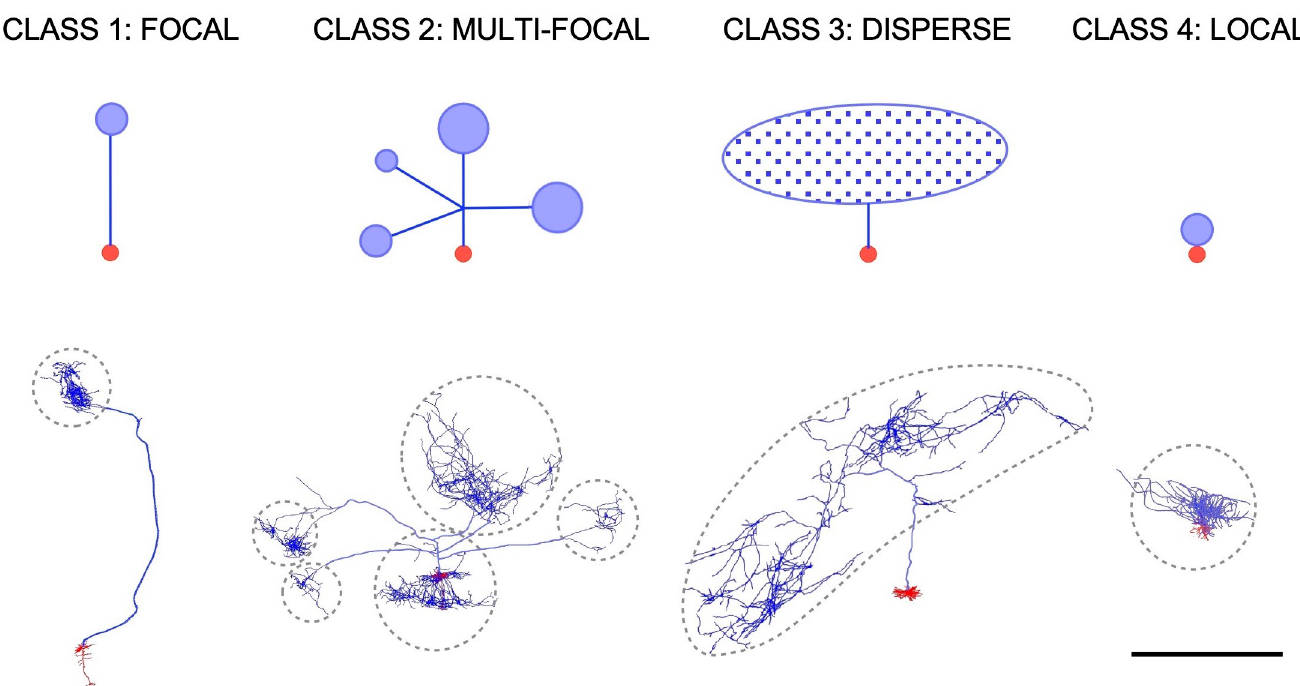
Fig 1. Neuron classification. Top. Schematic diagrams of the four neuronal classes defined in the study. Red circles represent the somatodendritic domain. Blue lines in class 1, class 2 and class 3 schemes represent the main axon trunk and collateral branches. Blue circles in class 1, class 2 and class 4 represent focal terminal arborizations of the axon. Blue oval filled with dots in class 3 represents a large and sparse axonal arborization. Bottom . One representative example of each neuronal class extracted from the NeuroMorpho dataset (Drawings generated from morphologies AA0641, AA0002, AA0051, AA0771 from Neuromorpho.org). Axon is represented in blue whereas dendrites and soma are depicted in red. Dashed contours enclose the spatial extent of the axonal arborizations. Scale bar, 1 mm.